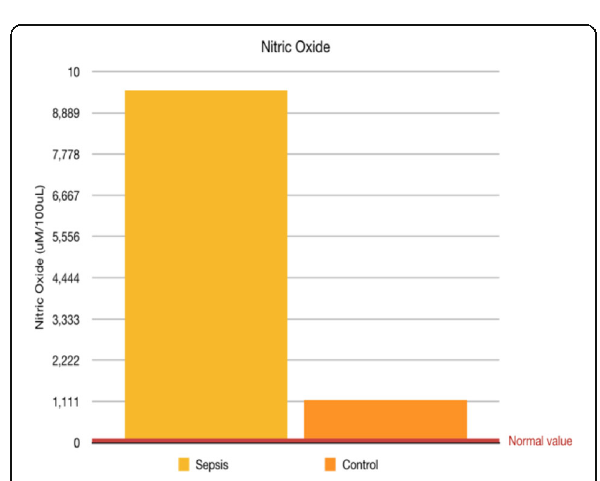
Fig. 3 (abstract 001692). See text for